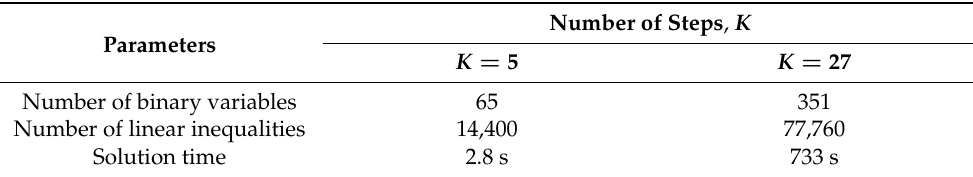
Figure 3. Path and sequence of deformation planned with the proposed method; A, C and E are rooms, and B and D are corridors Table 1. Parameters of the six-bar tensegrity drone path and morphing planning through three rooms connected via tilted shafts, with 5- and 27-step